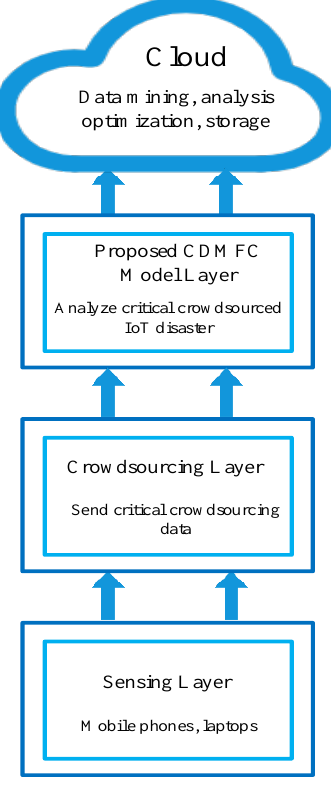
Figure 3. The hierarchical layered structure of CDMFC model for natural disaster